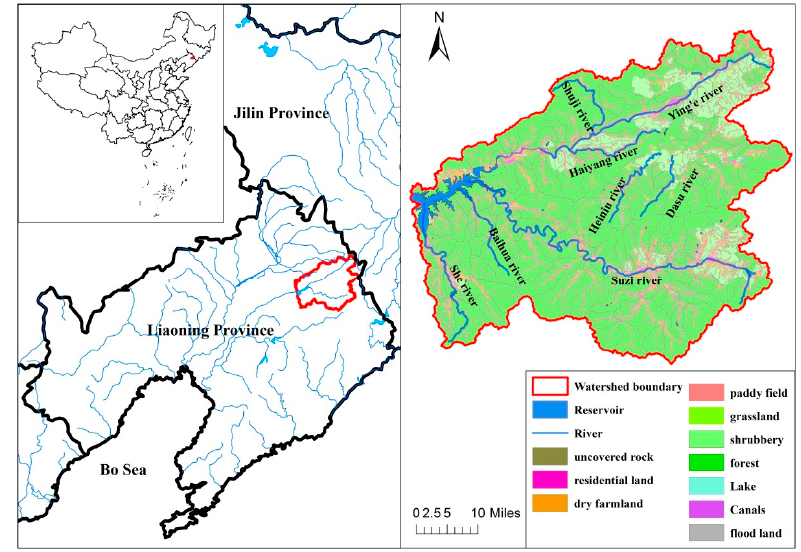
Figure 1. Subwatersheds and major land uses in the Dahuofang watershed. The 11,000 ha reservoir is shown in blue in the eastern portion of the basin.